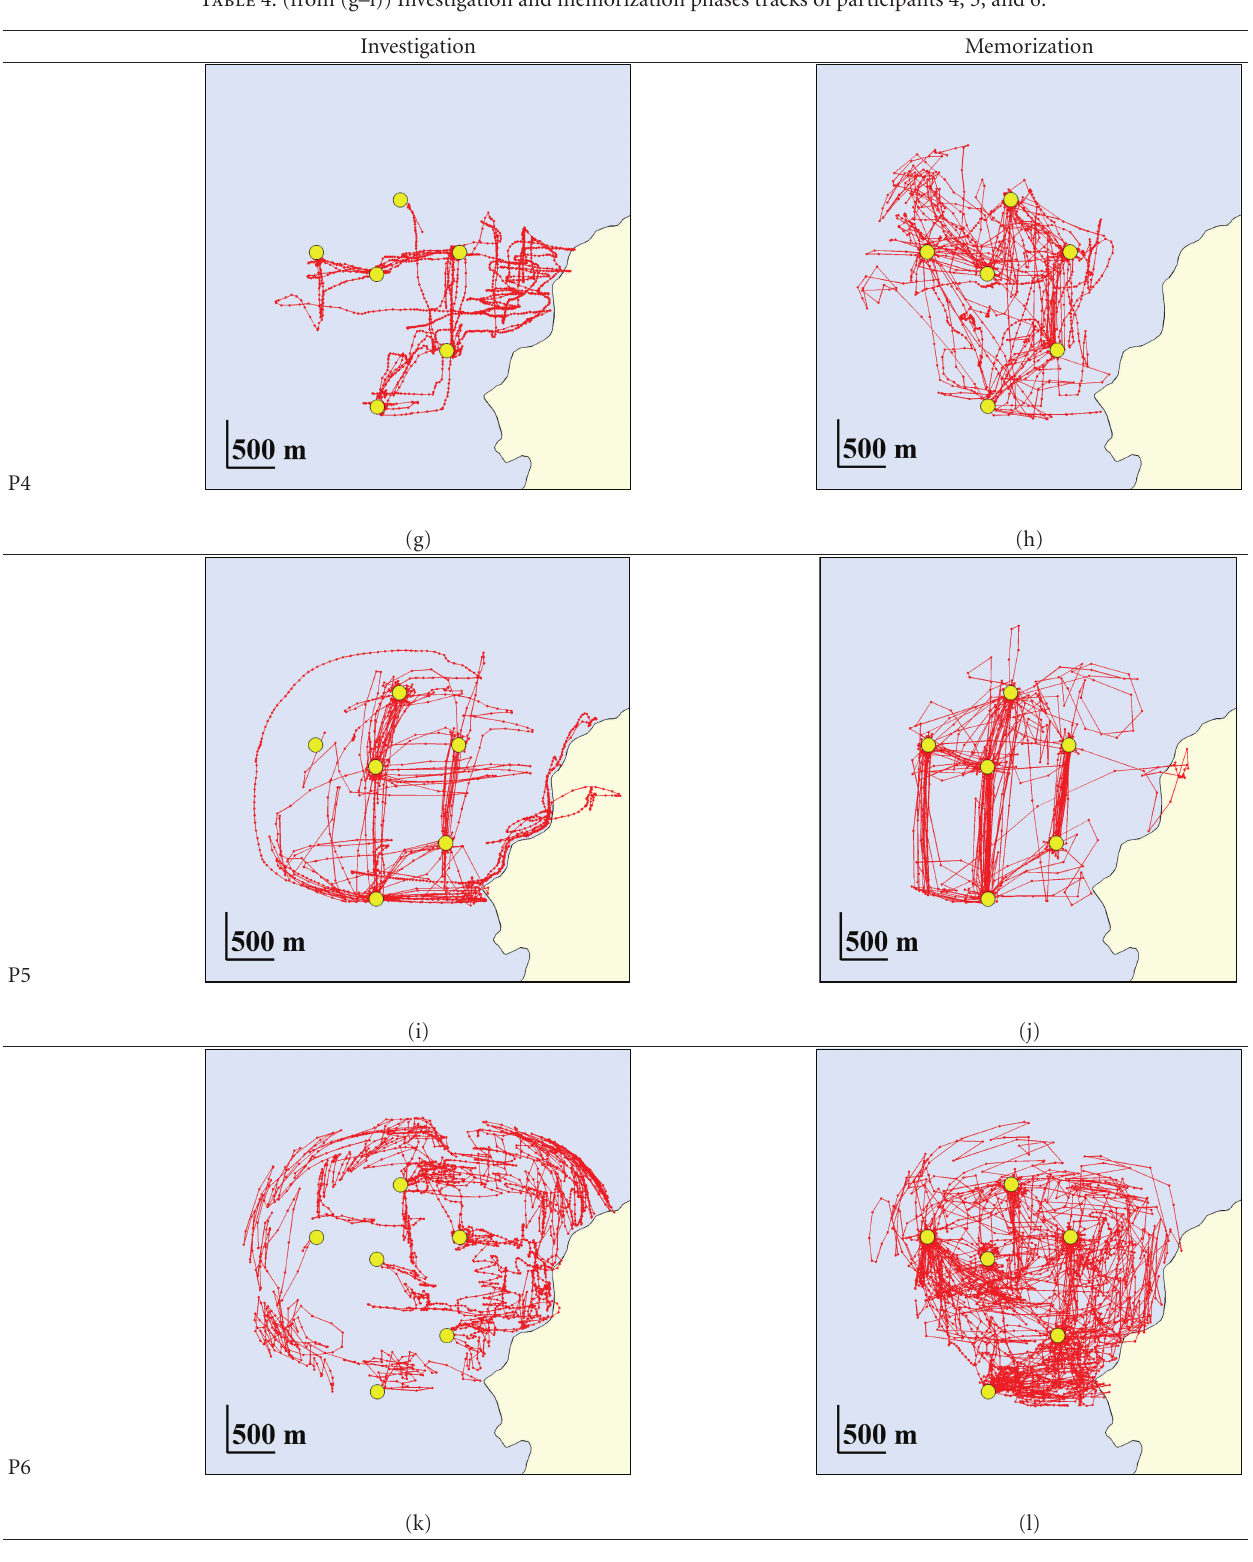
Table 4: (from (g–l)) Investigation and memorization phases tracks of participants 4, 5, and